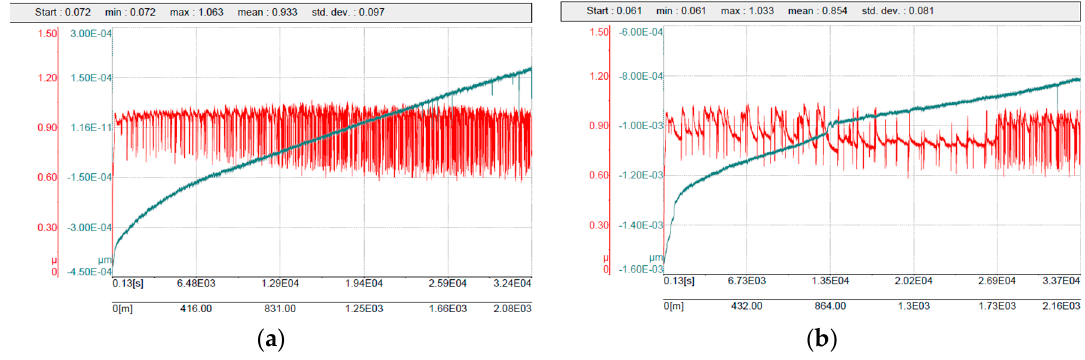
Figure 11. Friction coefficient curves: ( a ) 316L/0.33 wt% Al 2 O 3 ; ( b ) 316L/1 wt% Al 2 O 3 .